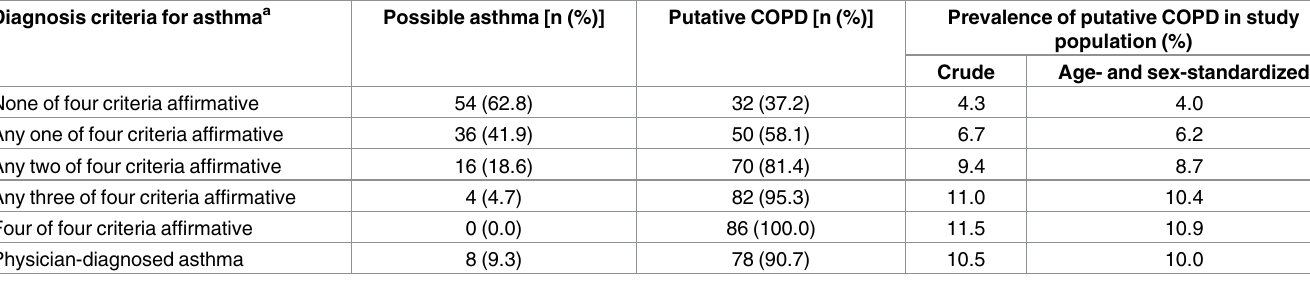
Table 4. Prevalence of putative COPD by diagnostic category of